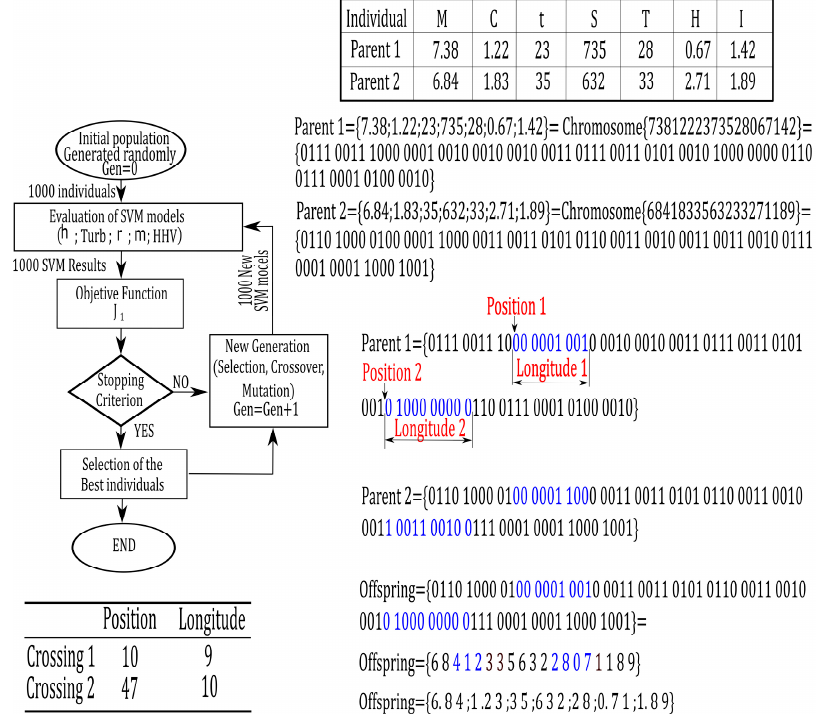
Figure 2. Script development in R language to implement the optimization based on GA and details of the crossovers and mutations of the individuals.